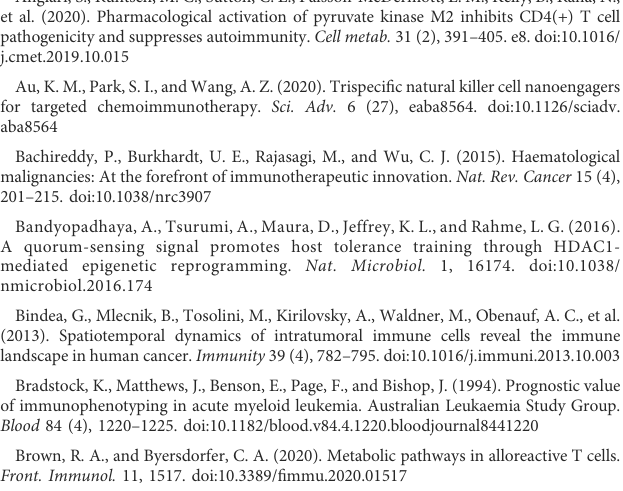
SUPPLEMENTARY TABLE S6 Gene Set Enrichment